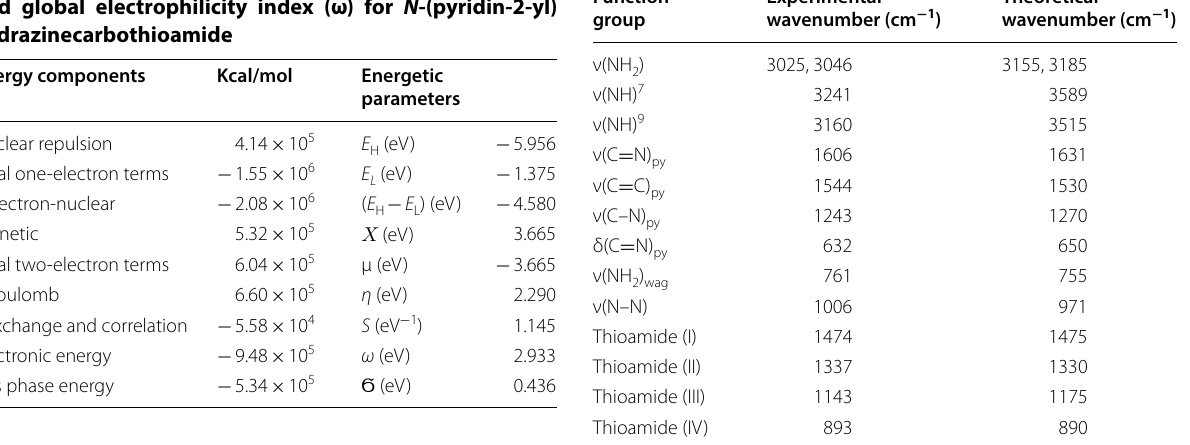
Table 5 Calculated energy components, E , E , Table 6 Expermintal and theoretical wavenumber (cm − 1 HOMO LUMO energy band gap ( E E ), chemical potential (μ), elec- H − L tronegativity (χ), global hardness (η), global softness (S) and global electrophilicity index (ω) for N -(pyridin-2-yl)